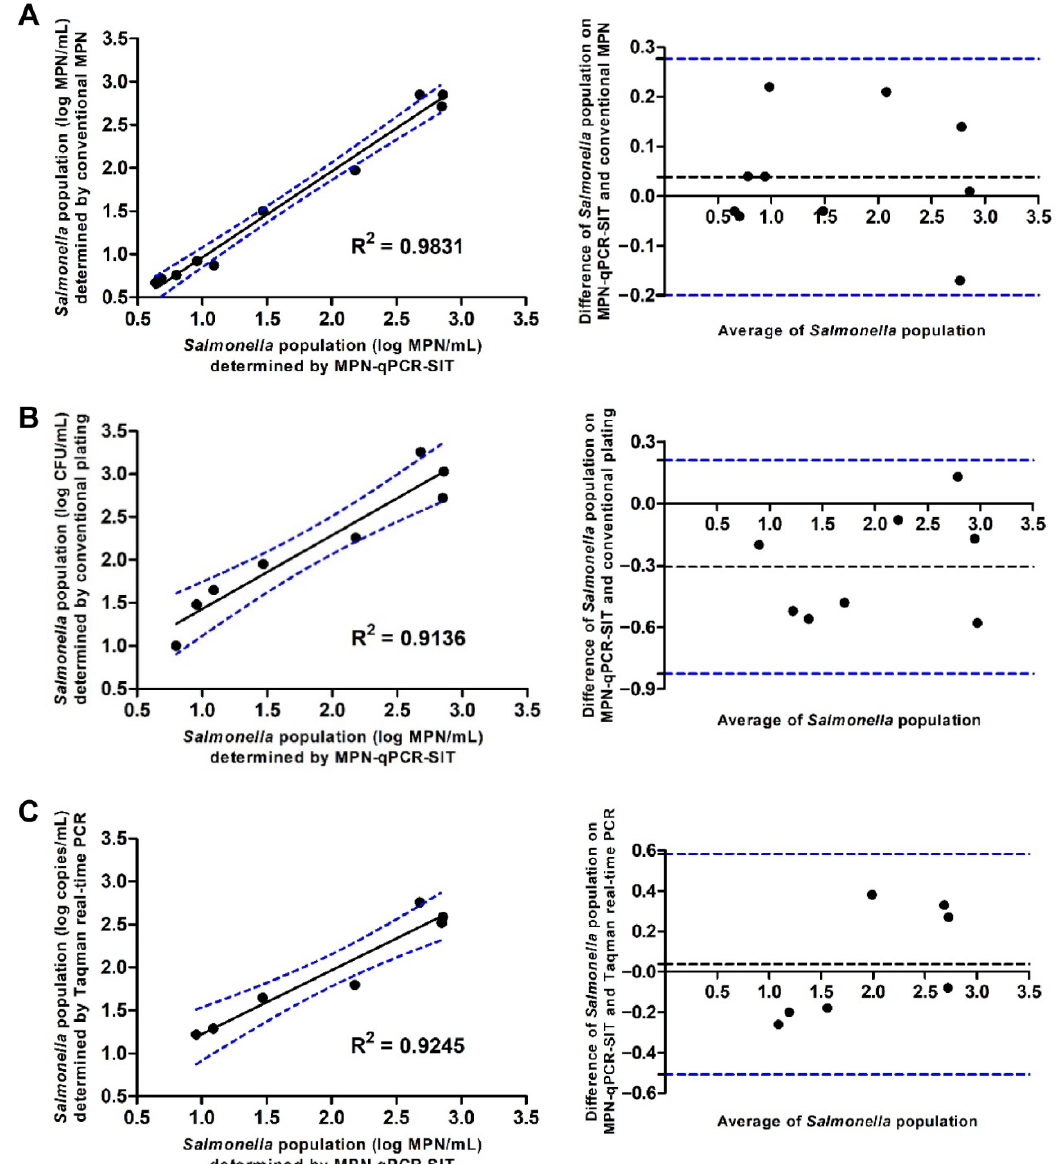
Figure 3. Scatter plots and Bland–Altman plots to present correlative relationships to evaluate the 95% agreement boundaries by comparison of the MPN-qPCR-SIT with other methods (y-axis) in- cluding ( A ) traditional MPN, ( B ) traditional plating, and ( C ) TaqMan real-time PCR for the quantification of S. enteritidis in bacterial cell suspensions.